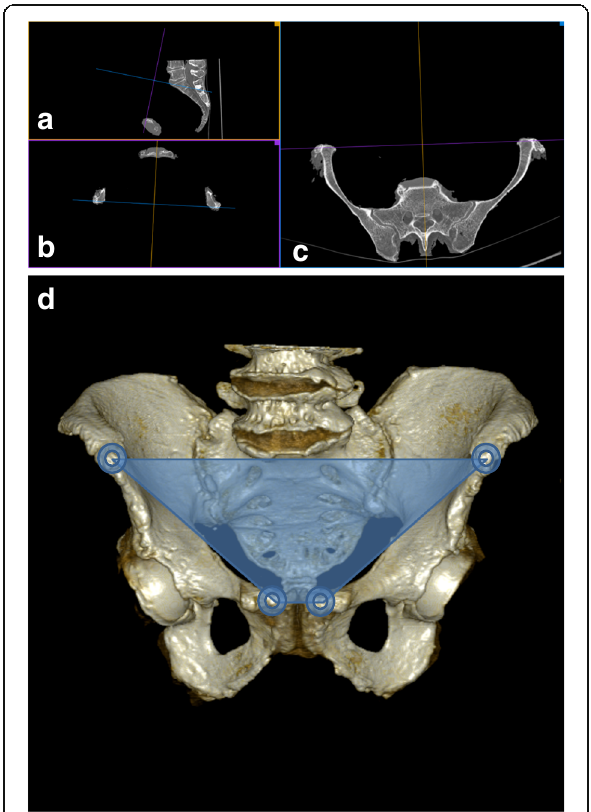
Fig. 4 The pelvic orientation was exactly adjusted to the APP in all spatial planes. a Adjusted sagittal reconstruction. b Adjusted coronal reconstruction: this is the APP connecting the upper boarder of the pubic symphysis and the anterior facet of the superior anterior iliac spines. c Adjusted sagittal reconstruction. (purple line: adjusted coronal plane, APP; blue line: adjusted axial plane; yellow line: adjusted sagittal plane) d CT 3D reconstruction of a pelvic specimen adjusted to the APP (blue